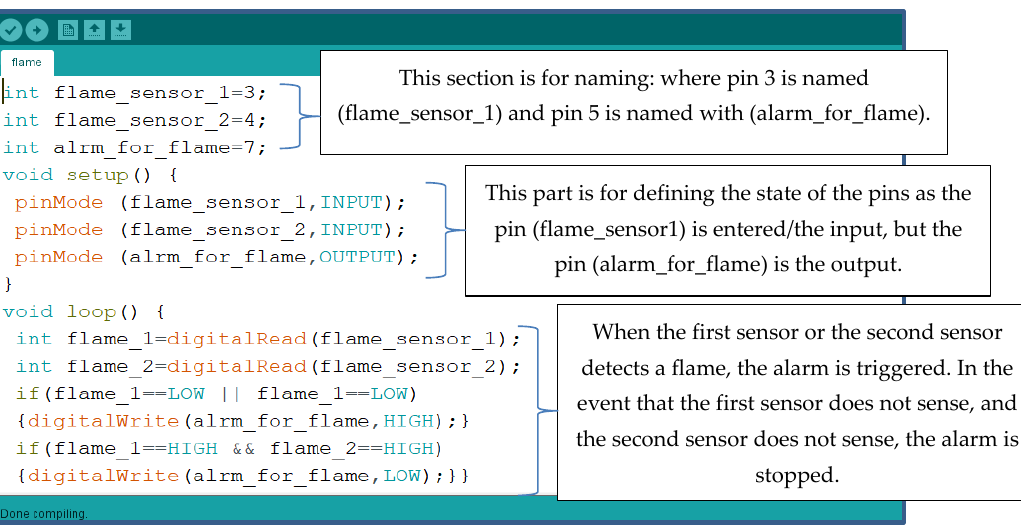
Figure A7. The implemented code for the fire alarm system.